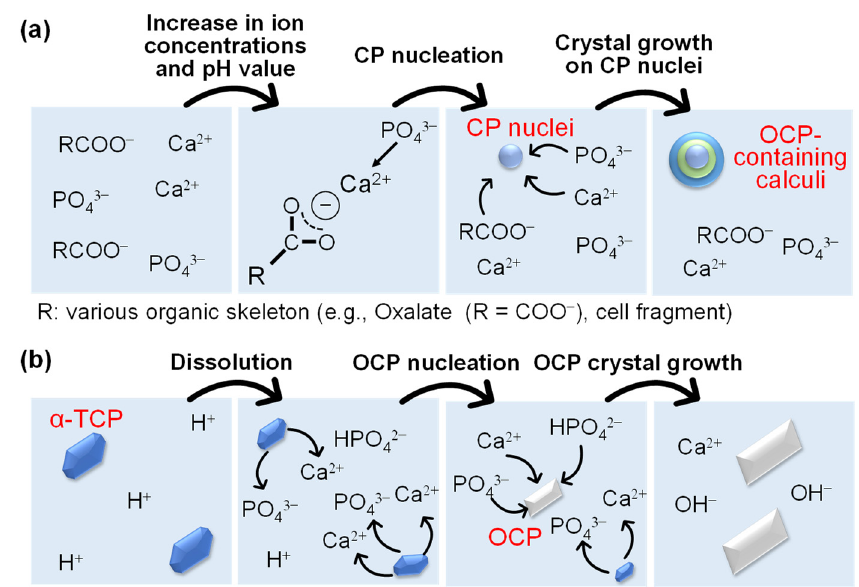
Figure 3. Possible illustrations of ( a ) formation process of OCP-containing calculi in vivo and ( b ) OCP synthesis by α -TCP hydrolysis in vitro.